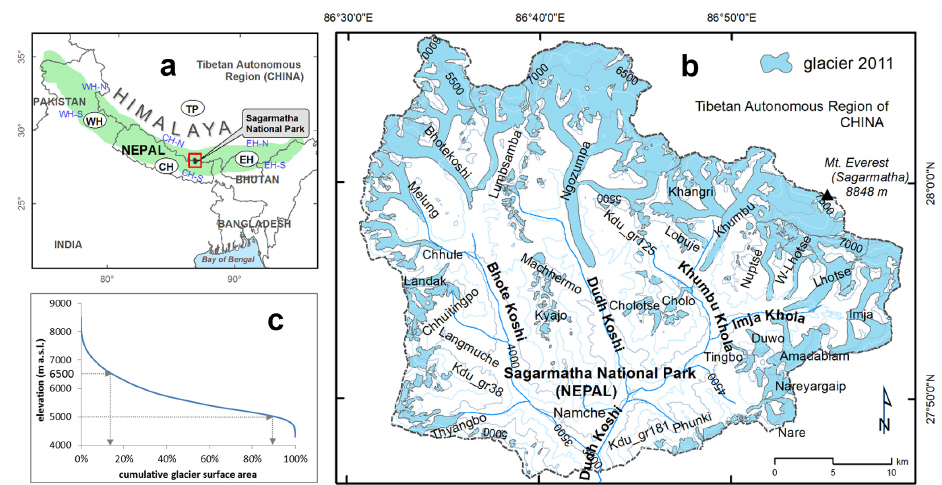
Figure 1. (a) Location of the study area: the Sagarmatha National Park (SNP), where the abbreviations CH, WH, EH, and TP represent the central Himalaya, the western Himalaya, the eastern Himalaya, and the Tibetan Plateau, respectively (suffixes -N and -S indicate the northern and southern slopes). (b) Focused map of the SNP in 2011 showing the distribution of 29 glaciers considered in this study with a surface area > 1km 2 . (c) The hypsometric curve of the glaciers in